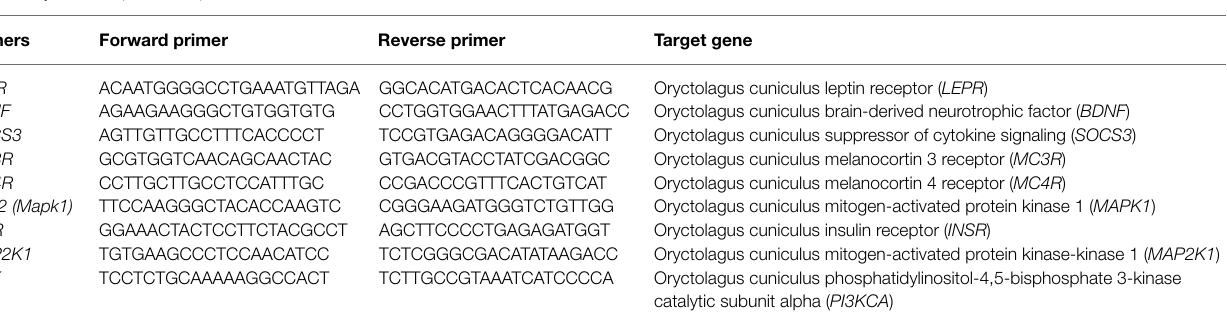
TABLE 1 | RT-PCR primer